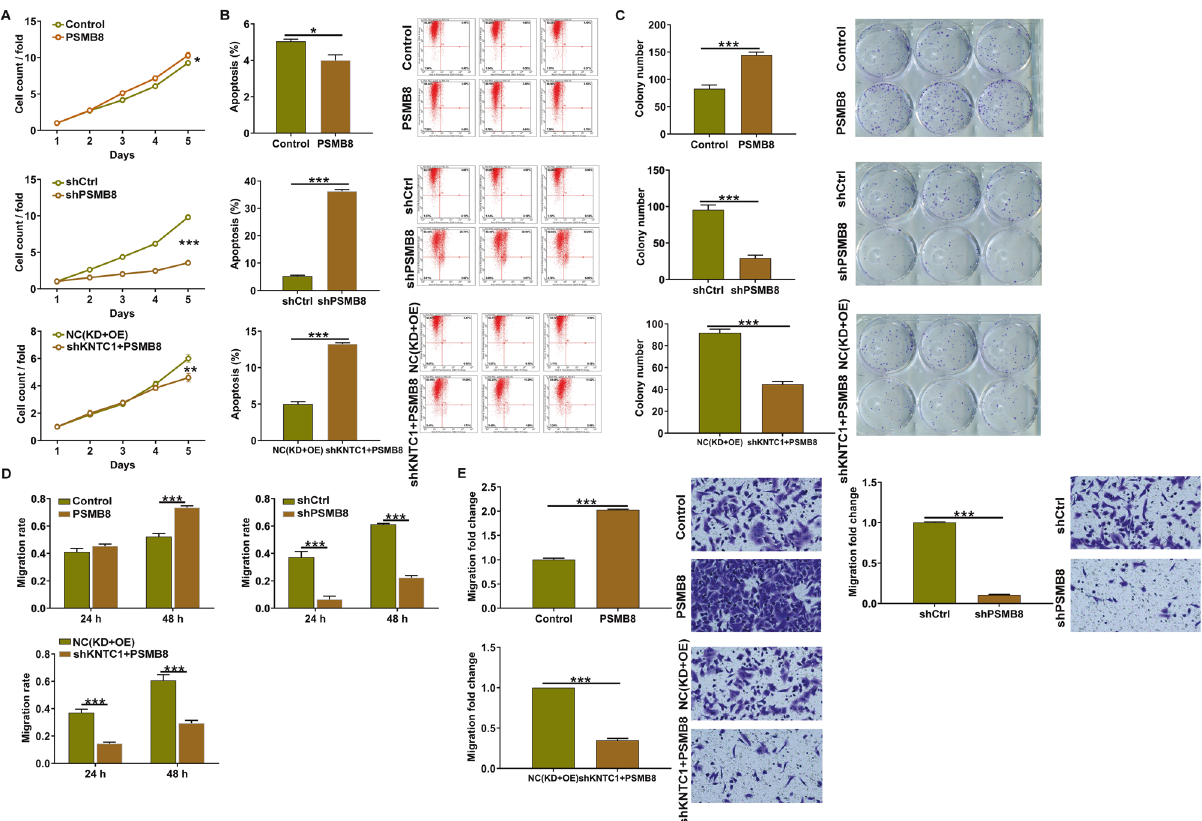
Fig. 4 Knockdown of KNTC1 rescued the promotion effects on NSCLC by PSMB8 overexpression. A Celigo cell counting assay was employed to show the synergistic effects of KNTC1 and PSMB8 on A549 cell proliferation. B The fl ow cytometry was performed to show the synergistic effects of KNTC1 and PSMB8 on A549 cell apoptosis. C Colony formation assay was used to evaluate the ability of A549 cells to form colonies in PSMB8, shPSMB8 and shKNTC1 + PSMB8 groups. D The migration rate of cells was detected in PSMB8, shPSMB8 and shKNTC1 + PSMB8 groups by wound-healing assay. E The migration rate of cells was detected in PSMB8, shPSMB8, and shKNTC1 + PSMB8 groups by transwell assay. * P < 0.05, ** P < 0.01, *** P <